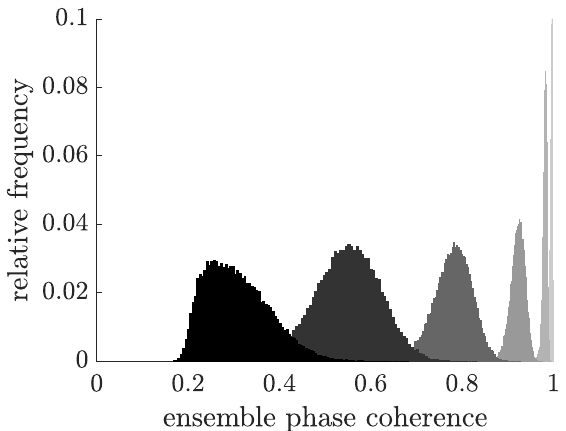
Figure 13. Relative frequency of occuring EPC values using simulated annealing. The darker the color of the histogram, the higher the noise level. It varies from 0.1rad to 0.6rad.